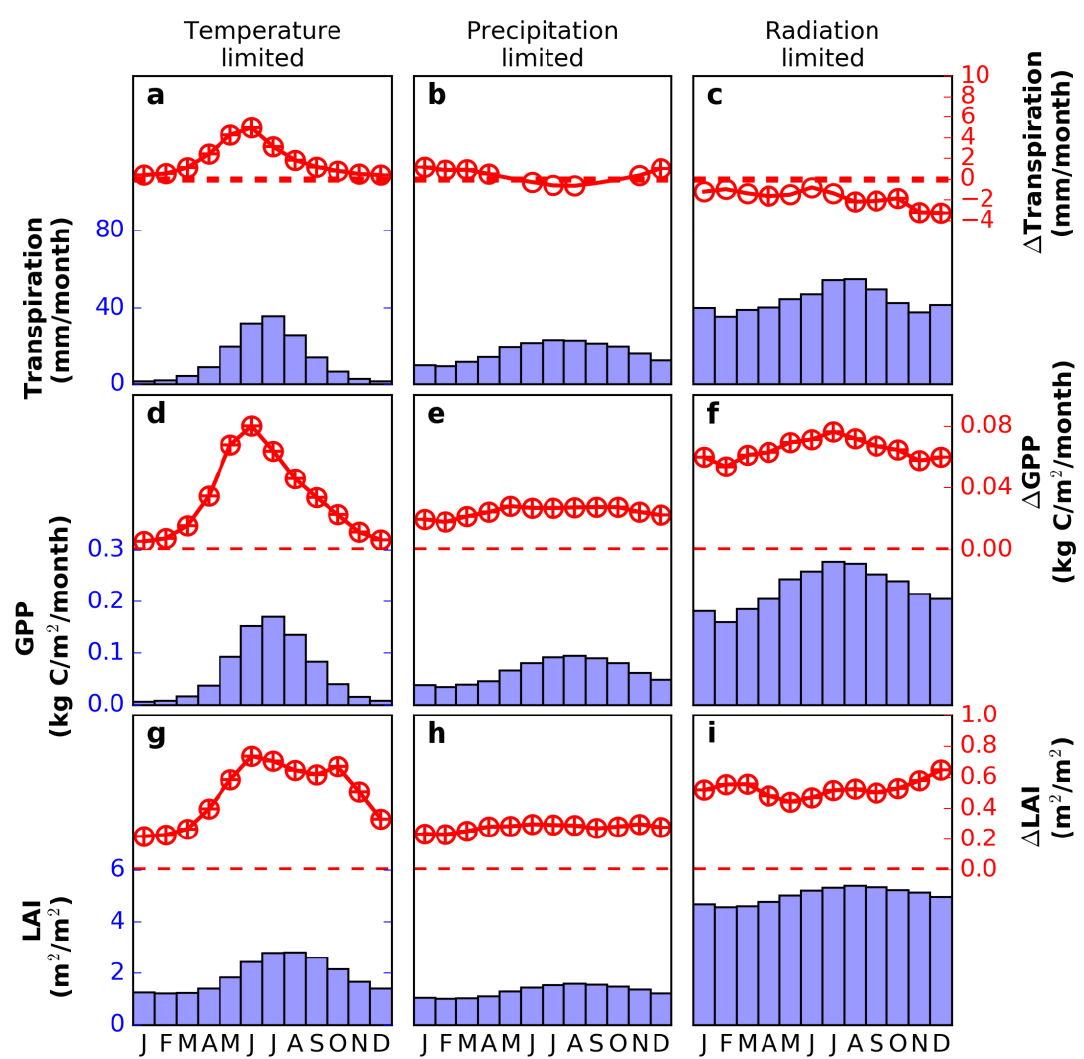
Figure 6. Easing of seasonal constraints to vegetation growth. Same was Figure 5, except for transpiration, a – c ; GPP, d – f ; and LAI, g – i transpiration, a – c ; GPP, d – f ; and LAI, g – i .